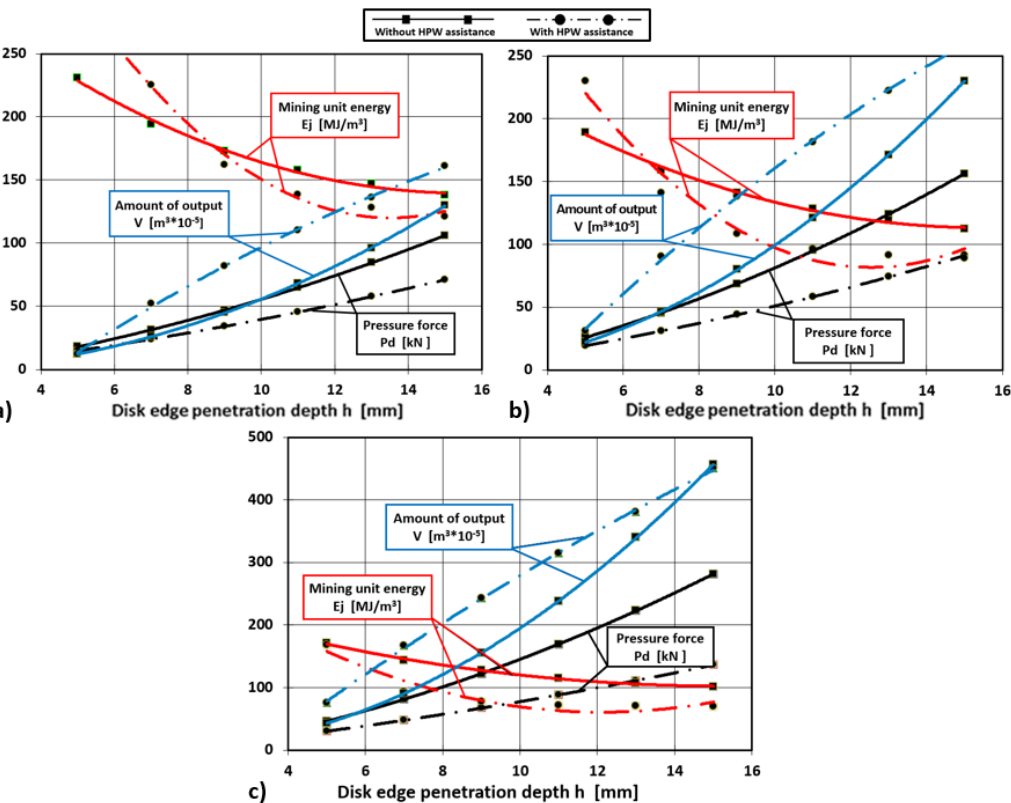
Figure 21. The value change of the pressure force Pd, the amount of output V and the mining unit energy Ej for mining with disk tool without and with HPW jets assistance, for the same mining parameters, as a function of disk edge penetration depth h: ( a ) disk edge angle 2 β = 90°, nozzle spacing 2B = 50 mm, ( b ) disk edge angle 2 β = 110°, nozzle spacing 2B = 70 mm, ( c ) disk edge angle 2 β = 130°, nozzle spacing 2B = 100 mm [1].